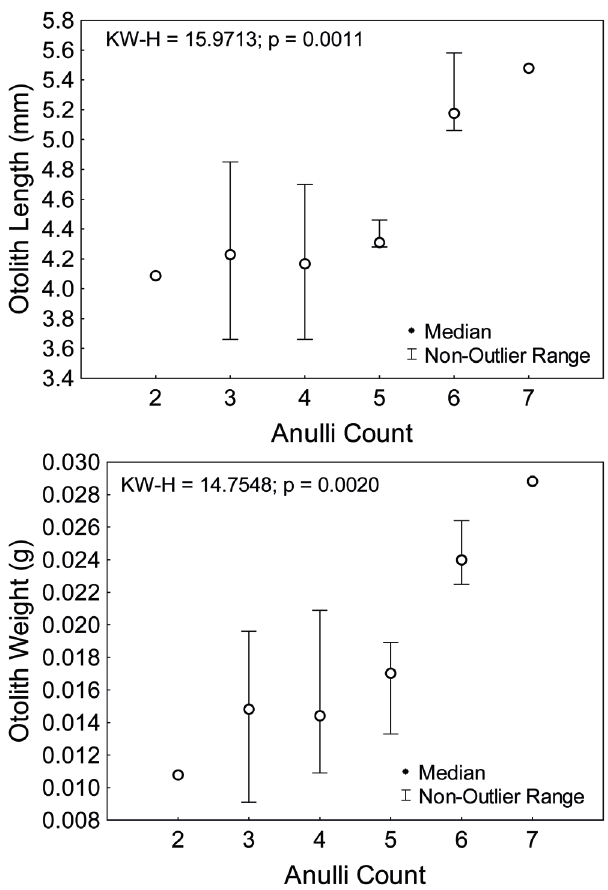
Fig. 6. Kruskall-Wallis results of the lapillus length and wei- ght in each Prochilodus lineatus age; ages 2 and 7 were not included in analysis because they only have one